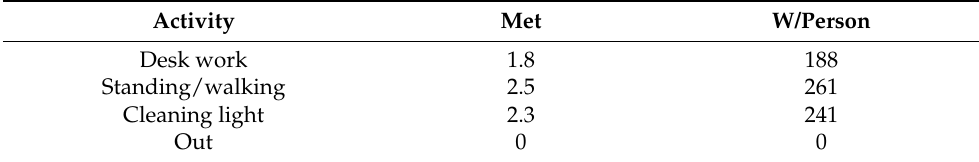
Table 1. Activities considered for the energy simulation. Activity Met W/Person Desk work 1.8 188 Standing/walking 2.5 261 Cleaning light 2.3 241 Out 0